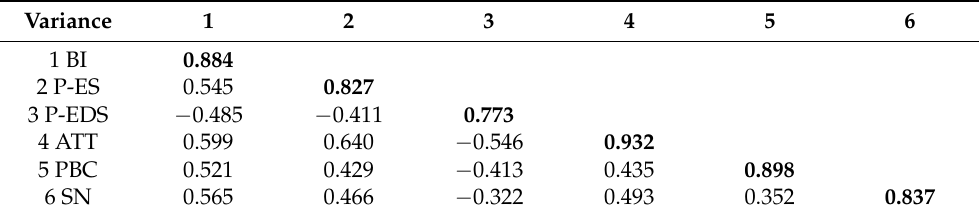
Table 5. Discriminant validity: average variance extracted (AVE) and shared variances.